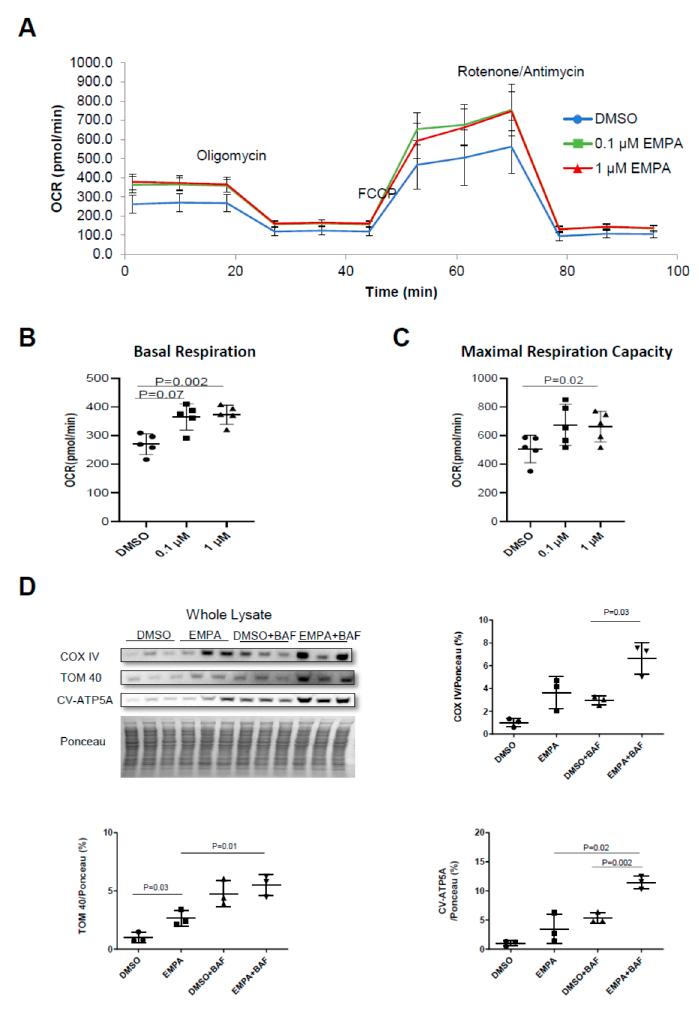
Figure 2. EMPA directly improves mitochondrial quality in H9C2 cells. H9C2 cells were pretreated with DMSO (0.01% v / v ), 0.1 µ M or 1 µ M EMPA for 24 h, then oxygen consumption rates were measured with seahorse mito stress test. ( A ) Mito stress test respirometry profile of DMSO or EMPA- treated cells; ( B ) quantification of basal respiration; ( C ) quantification of maximal respiration capacity ( n = 3). ( D ) Western blot analysis and quantification of mitochondria biogenesis markers COX IV, CV-ATP5A and TOM40 in whole cell lysates ( n = 3).